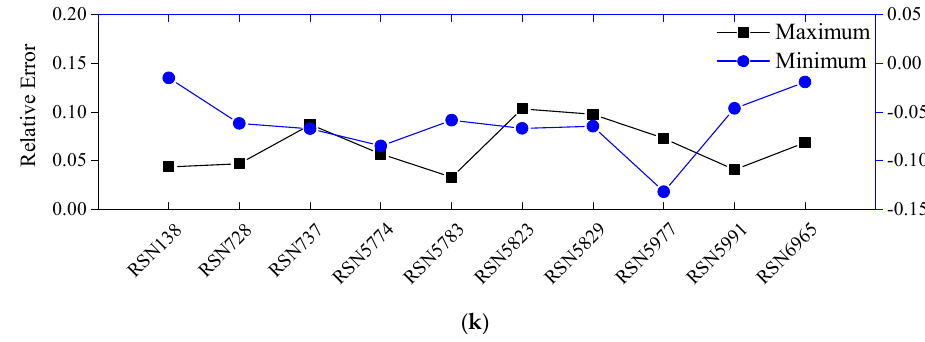
Figure 20. Comparison of story moments of each ground motion between RC and GSPCW models: ( a ) RSN138; ( b ) RSN728; ( c ) RSN737; ( d ) RSN5774; ( e ) RSN5783; ( f ) RSN5823; ( g ) RSN5829; ( h ) RSN5977; ( i ) RSN5991; ( j ) RSN6965; ( k ) Relative error.